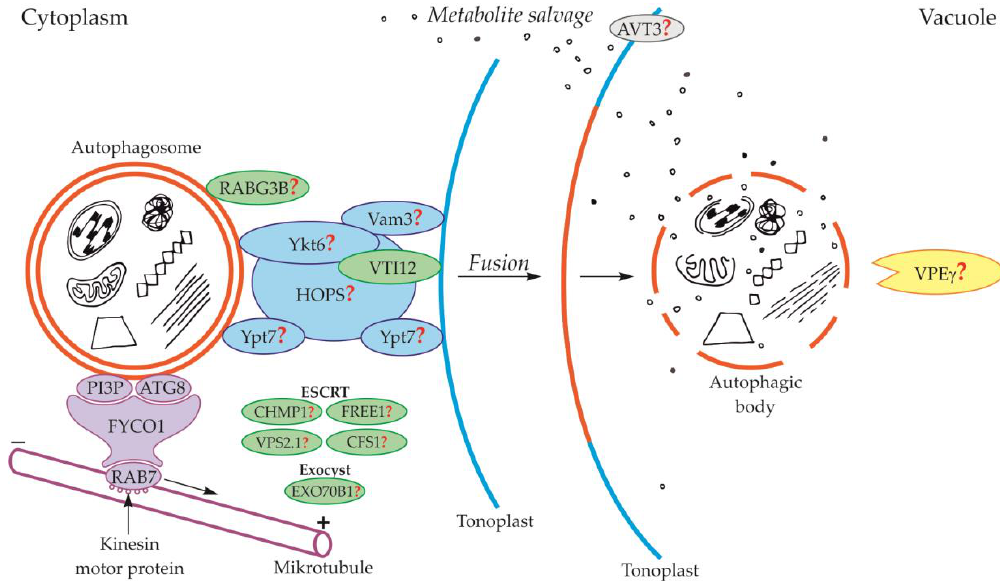
Figure 3. Schematic diagram depicting trafficking and fusion of the autophagosome to the vacuole and the degradation of the autophagic body inside the vacuole in plants. PI3P and ATG8 anchored in the outer membrane of the autophagosome are involved in autophagosome trafficking and bind autophagosome with FYCO1 protein. The complex autophagosome-FYCO1-RAB7 moves along microtubules in the direction of the plus end by the binding of RAB7 to kinesin motor proteins. Protein VTI12 is involved in the fusion of the autophagosome and vacuole. RABG3B is located on the surface of the autophagosome but the involvement of this protein in the fusion of the autophagosome and vacuole in plants remains unclear. It is suggested that the homologous yeast proteins Ykt6, Vam3, Ypt7, and complex HOPS are involved in the fusion of autophagosome and vacuole in plants. Additionally, it is suggested that plant proteins CHMP1, FREE1, VPS2.1, CFS1, and the complex EXO70B1 are involved in the autophagosome trafficking, autophagosome-vacuole fusion, and the release of the autophagic body into the vacuole lumen. The newly formed autophagic body inside the vacuole is rapidly degraded by lytic enzymes. One of them can be the vacuolar processing enzyme γ (VPEγ). Proteins involved in metabolite efflux from the vacuole to the cytoplasm during autophagy in plants have not been described so far. Only permease AVT3 was confirmed in Arabidopsis thaliana , but the involvement of this permease in the transport of metabolites coming from the degradation of the autophagic body is not confirmed. Question marks indicate the hypothetical involvement of plant proteins and complexes, or plant homologs of yeast proteins, during autophagy. Table 1. Proteins involved, or hypothetically involved, in trafficking and fusion of the autophagosome to the vacuole and formation of the autophagic body during macroautophagy. Protein Organism Function